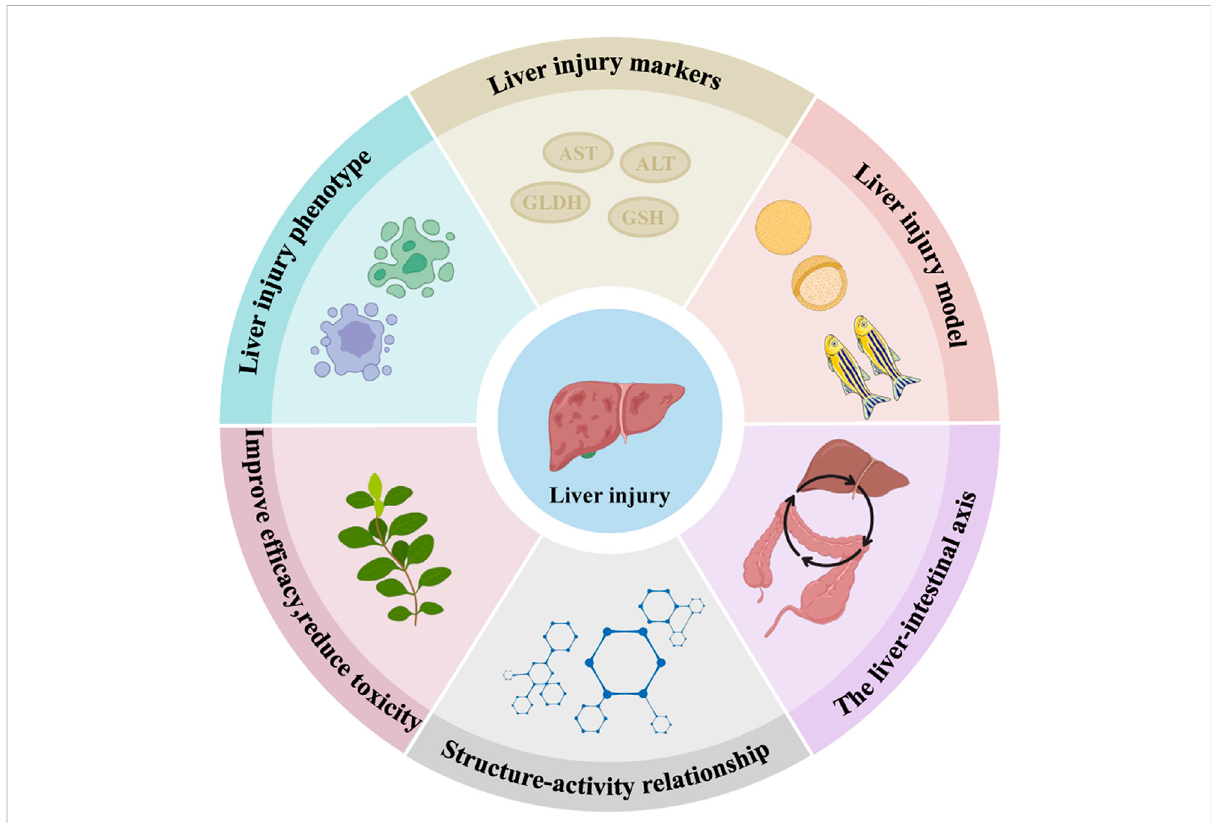
FIGURE 5 Predicted directions for later studies of INH and RFP-induced liver injury and the effects of natural medicinal ingredients. We predicted that the following six aspects might be studied in the future: Liver injury phenotype, liver injury markers, liver injury model, the liver-intestine axis, structure- activity relationship and improve ef fi cacy, reduce